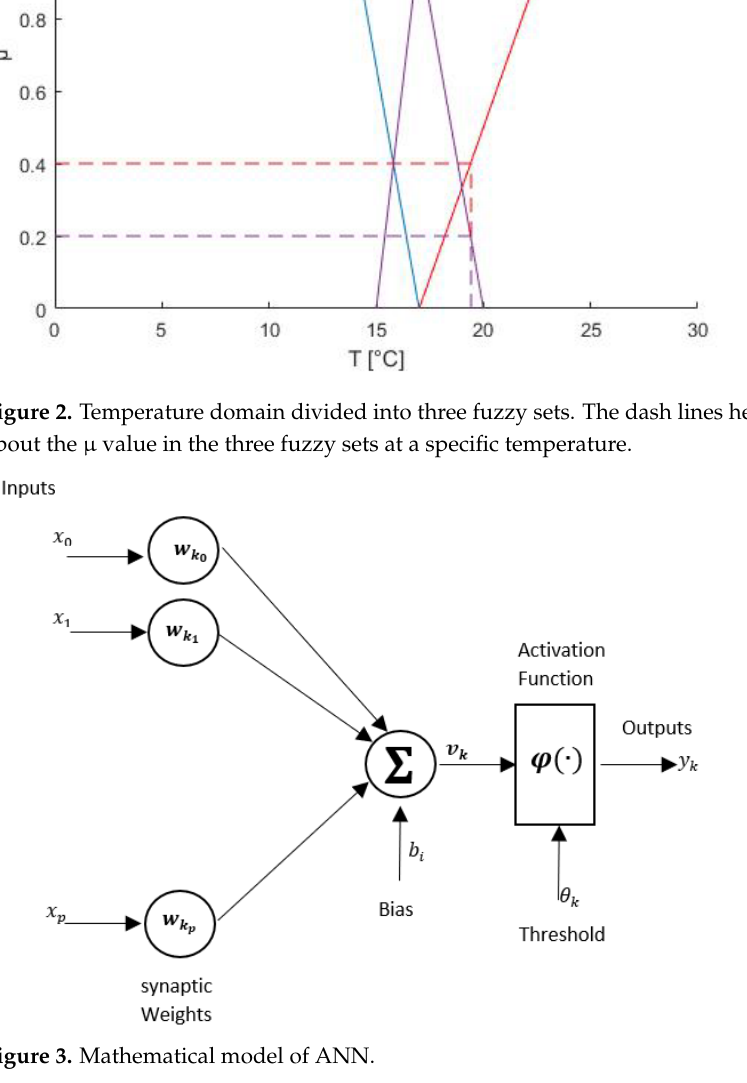
Figure 2. Temperature domain divided into three fuzzy sets . The dash lines help to take infor- mation about the µ value in the three fuzzy sets at a specific temperature.